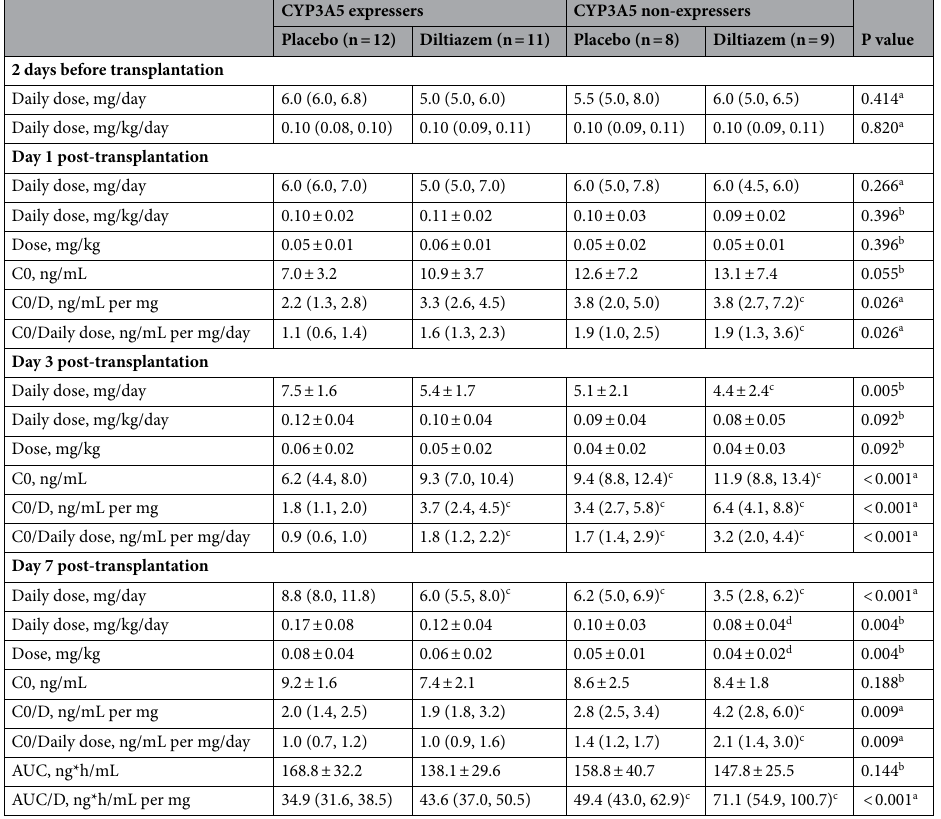
Table 2. Tacrolimus dose, concentration, and area under the 12-h concentration curve. Values are expressed as mean ± SD or median (interquartile range) for comparison reasons. AUC area under the concentration over 12-h curve, AUC/D dose-adjusted area under the concentration over 12-h curve, C0 trough concentration, C0/D dose-adjusted trough concentration. a Kruskal–Wallis test. b Analysis of variance. c P < 0.05 versus CYP3A5 expressers with placebo group (Bonferroni correction for multiple comparisons). d P < 0.05 versus CYP3A5 expressers with placebo group (Dunnett’s T3 correction for multiple